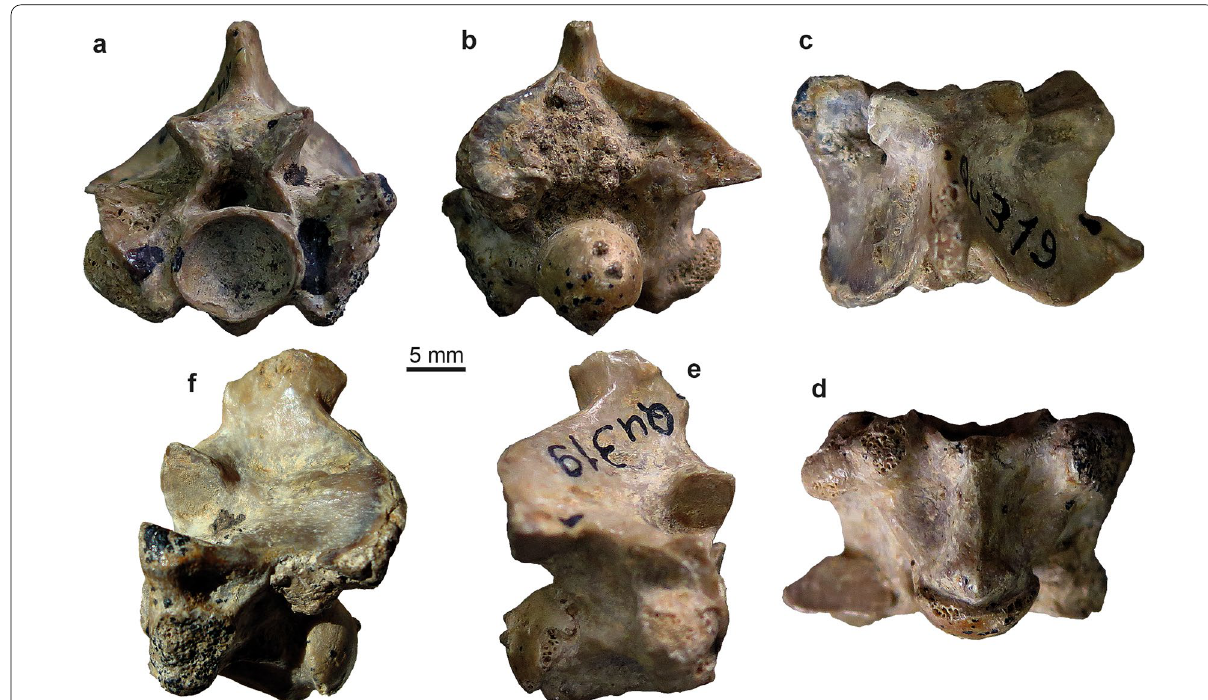
Fig. 8 Palaeopython cadurcensis from an imprecisely known locality in the Phosphorites du Quercy: mid-trunk vertebra (MNHN.F QU16319), formerly considered a syntype of the species, in anterior ( a ), posterior ( b ), dorsal ( c ), ventral ( d ), right lateral ( e ), and left lateral ( f) , views. This specimen was originally figured as a lithograph by Rochebrune (1884:pl. II.3 a –3 b